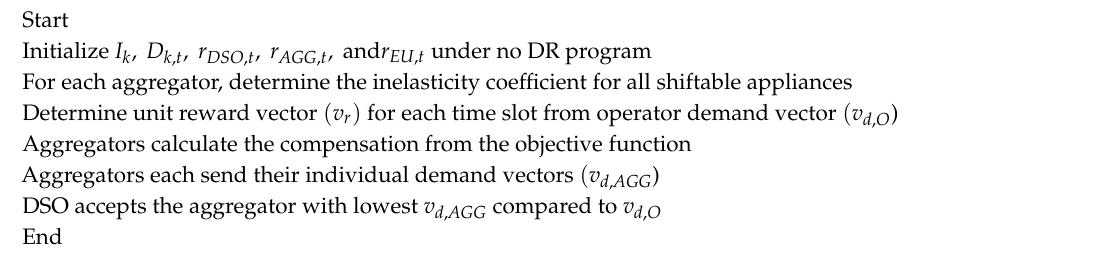
Algorithm 1. Procedure for rewarding the best-performing aggregator by DSO Start